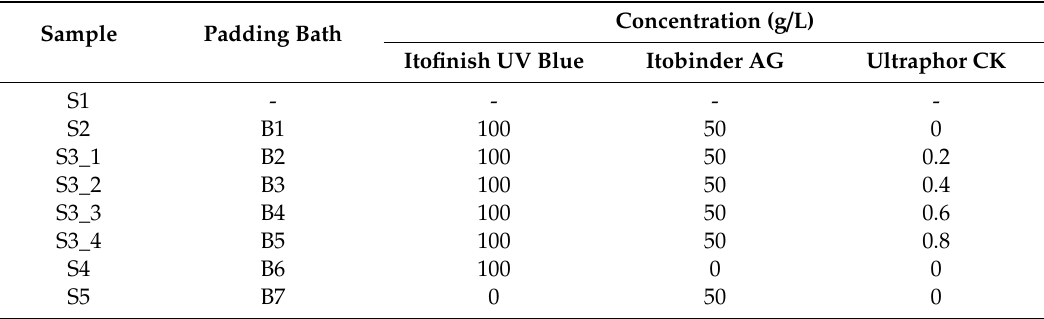
Table 1. Composition of the padding bath and sample